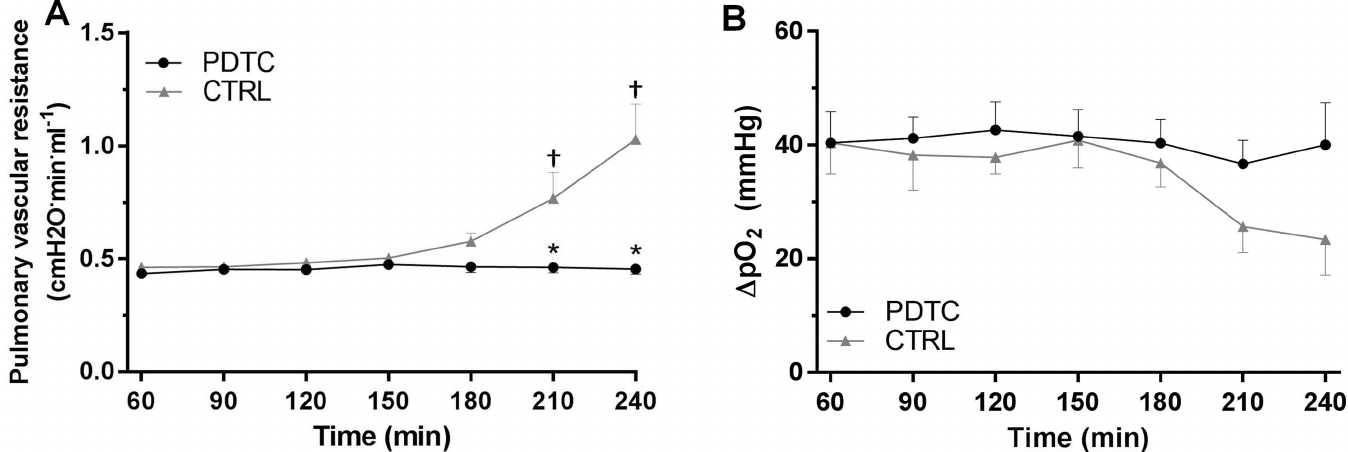
Fig 6. Pulmonary vascularresistance and oxygenation index during EVLP. Pulmonary vascular resistance(A) was calculatedas (mean pulmonary artery pressure - left atrial pressure)/perfusionflow). The oxygenation capacity (B) was calculatedas the difference in the partial pressure of O 2 betweenthe effluent and the affluent arms of the EVLP circuits. The vascular resistanceand oxygenation capacitywere computedafter 60 minutes of EVLP (baseline values), and every 30 minutes thereafter. Means ± s.e.m. † p < 0.05 vs baselinevalue; * p < 0.05PDTC vs CTRL (two way ANOVA with Bonferroni’s adjustments for